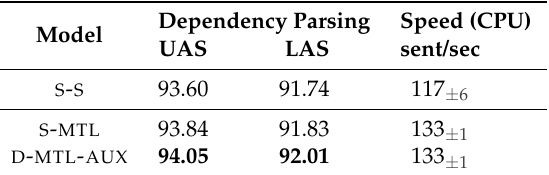
Table 2. Unlabeled Attachment Score (UAS), Labeled Attachment Score (LAS) and speed on a single core CPU for the MTL models on the PTB test sets. S - S : single model, S - MTL : 2-task, D - MTL - AUX : with constituency parsing as auxiliary